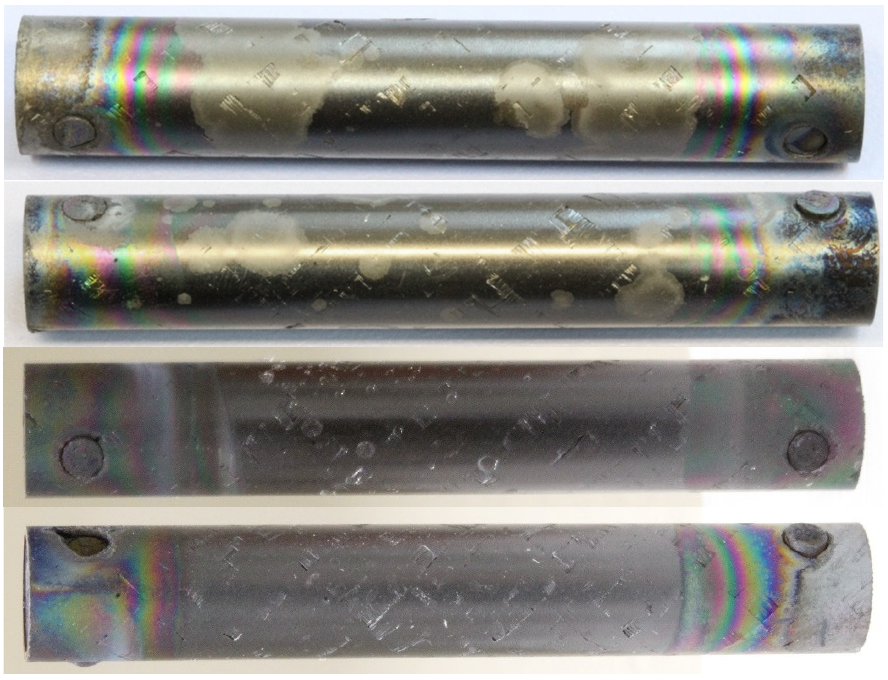
Figure 8. Post-test appearance of the samples after 1 h (3 h for SiC-04) isothermal oxidation at 1700 °C in steam.